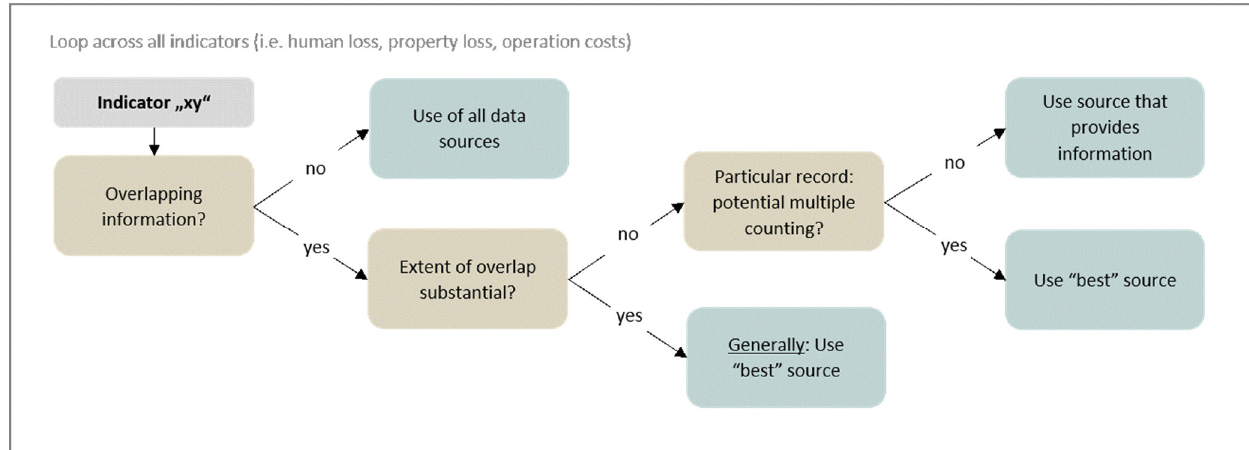
Figure 3. Selection process in the case of potentially overlapping loss information from heterogeneous sources.